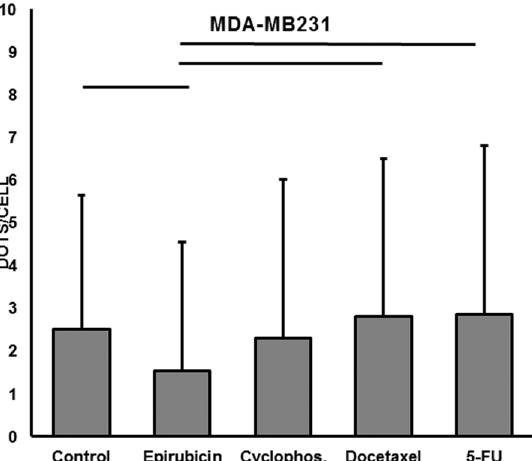
in MCF7 cells and the high basal level in MDA-MB231 cells. The LC3b antibody was diluted 1/400 (100x magnification).